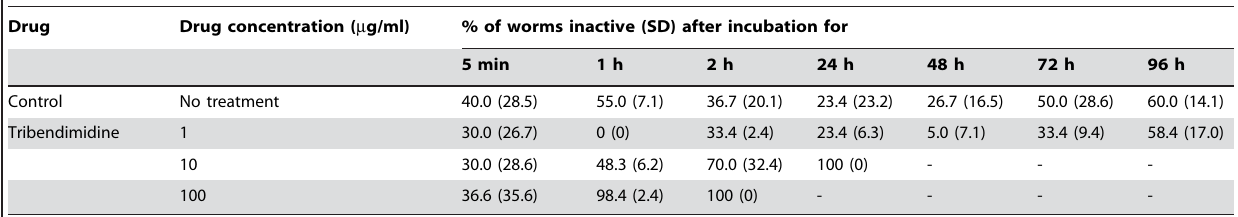
Drug Drug concentration ( m g/ml)